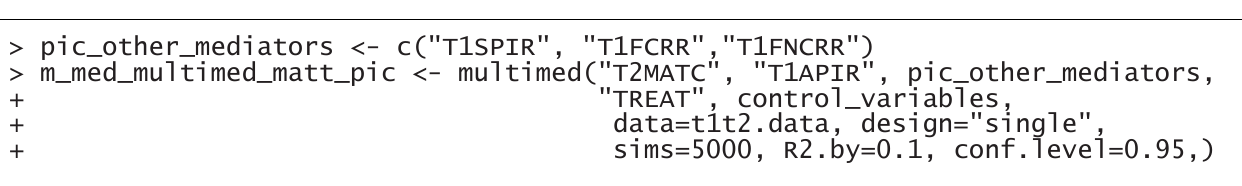
FIGURE 5 | R code for fitting causal mediation model with multiple mediators. In the multimed function, the outcome object, the mediator of interest, the post-treatment confounders, the covariate the treatment variable, are specified. Multiple covariates and confounders can be